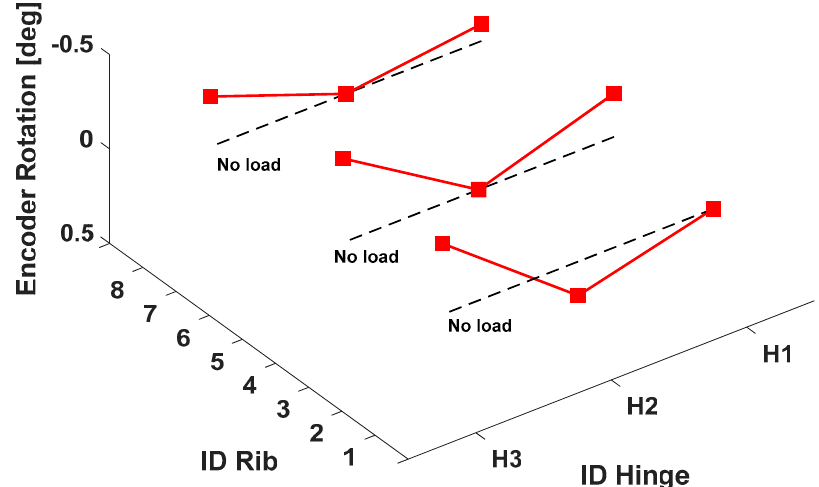
Figure 21. Deviation from the baseline configuration at rest: static load of 1520 N.